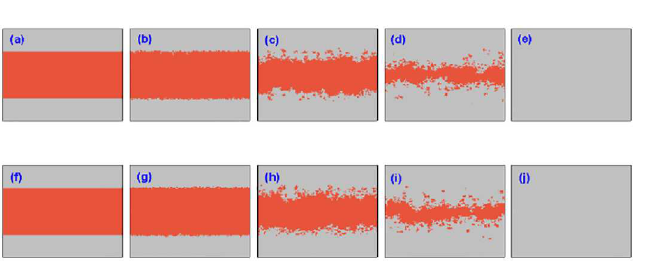
Fig 7. Characteristic snapshots of cooperators and defectors on two independent lattices for a fixed temptation to defect ( b = 1.07) starting from a prepared strategy distribution. In the upper row, from panel (a) to (e), snapshots are taken from one lattice at the time step 1, 10, 100, 1000, 50000,respectively; Similarly, in the lower row, we providethe snapshotson the other lattice at the same time step. The orange dots represent the cooperators, and the light gray dots denotethe defectors. The system setup is assumed to be L = 200, MCS = 5 × 10 4 , κ = 0.1 and the tunableparameter α =